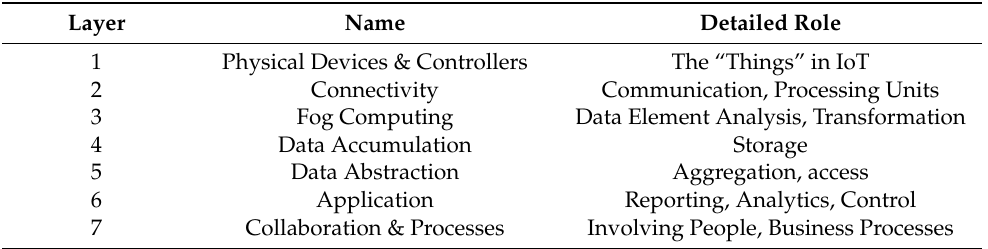
Table 1. CISCO’s Internet of Things Reference Model.